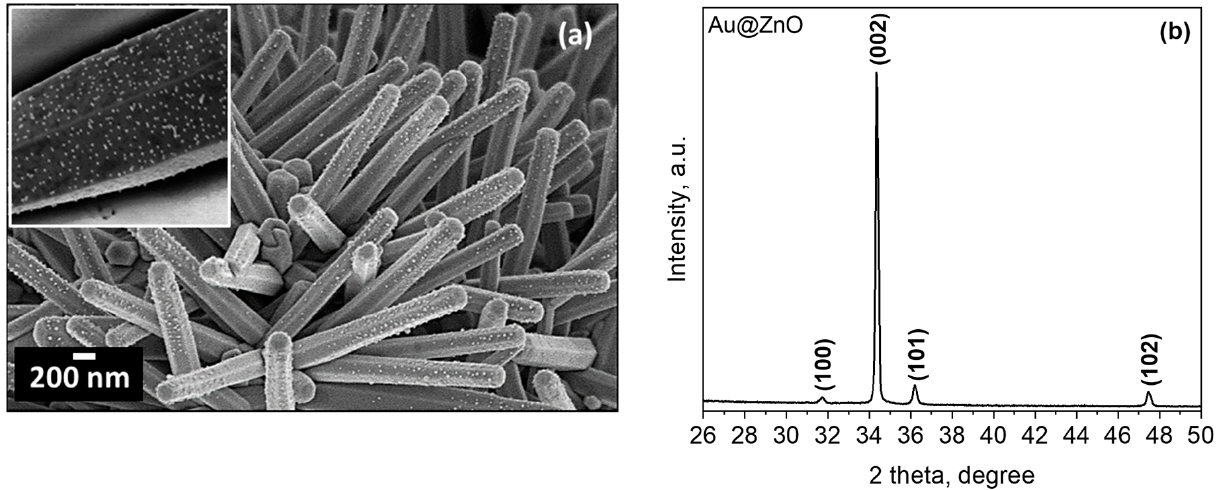
Figure 1. ( a ) SEM images (the inset shows a magnified image of a single Au decorated ZnO rod). ( b ) XRD diffraction pattern of the Au@ZnO structured film; all of the diffraction peaks in the data can be indexed to a hexagonal ZnO phase (P63mc space group, ICDD card No. 00-005-0664).